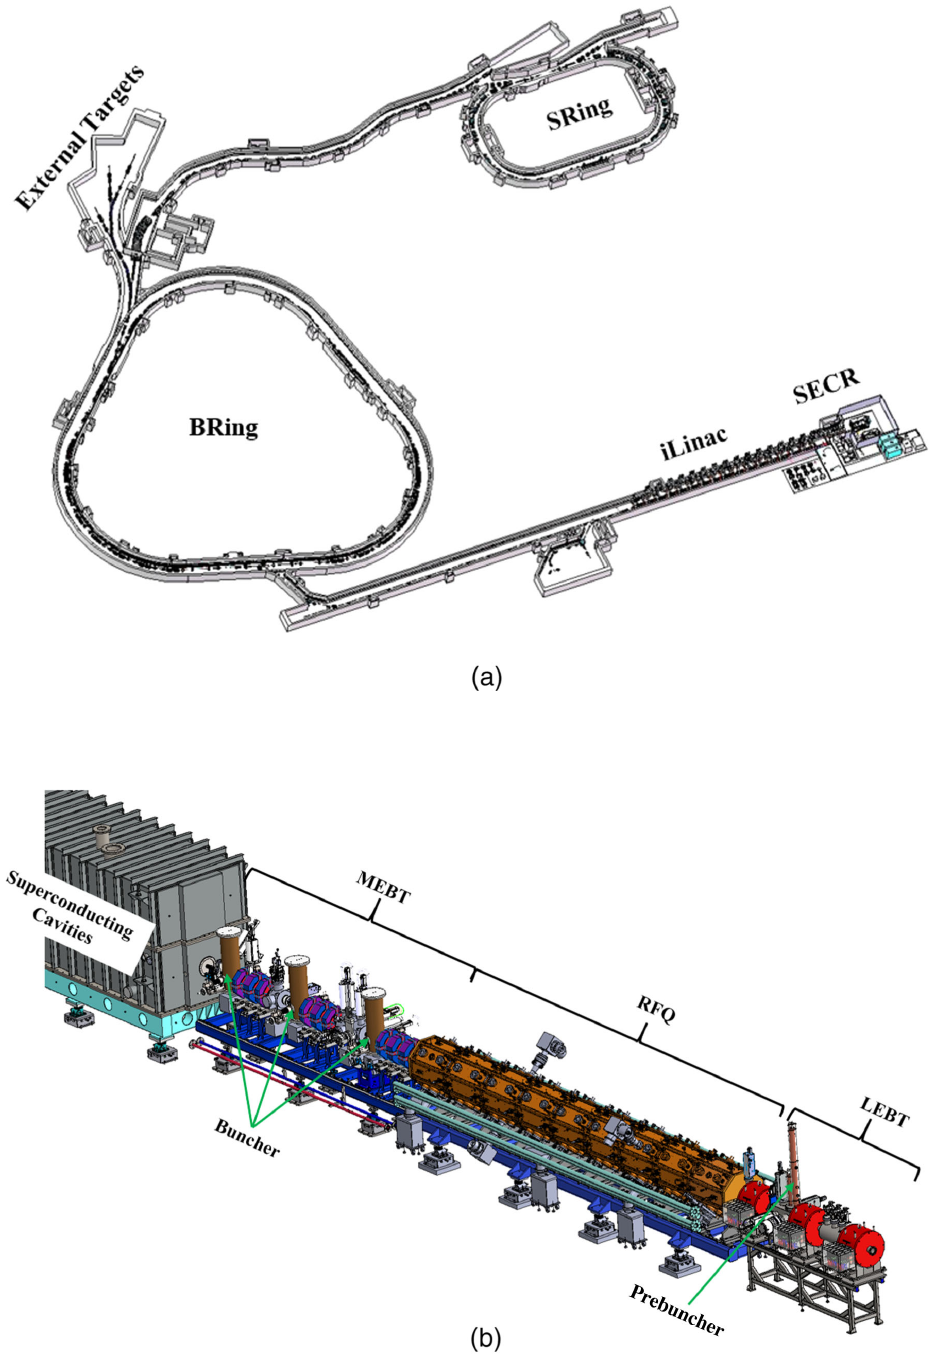
FIG. 1. (a) Layout of the HIAF project; (b) Layout of the HIAF injector linac